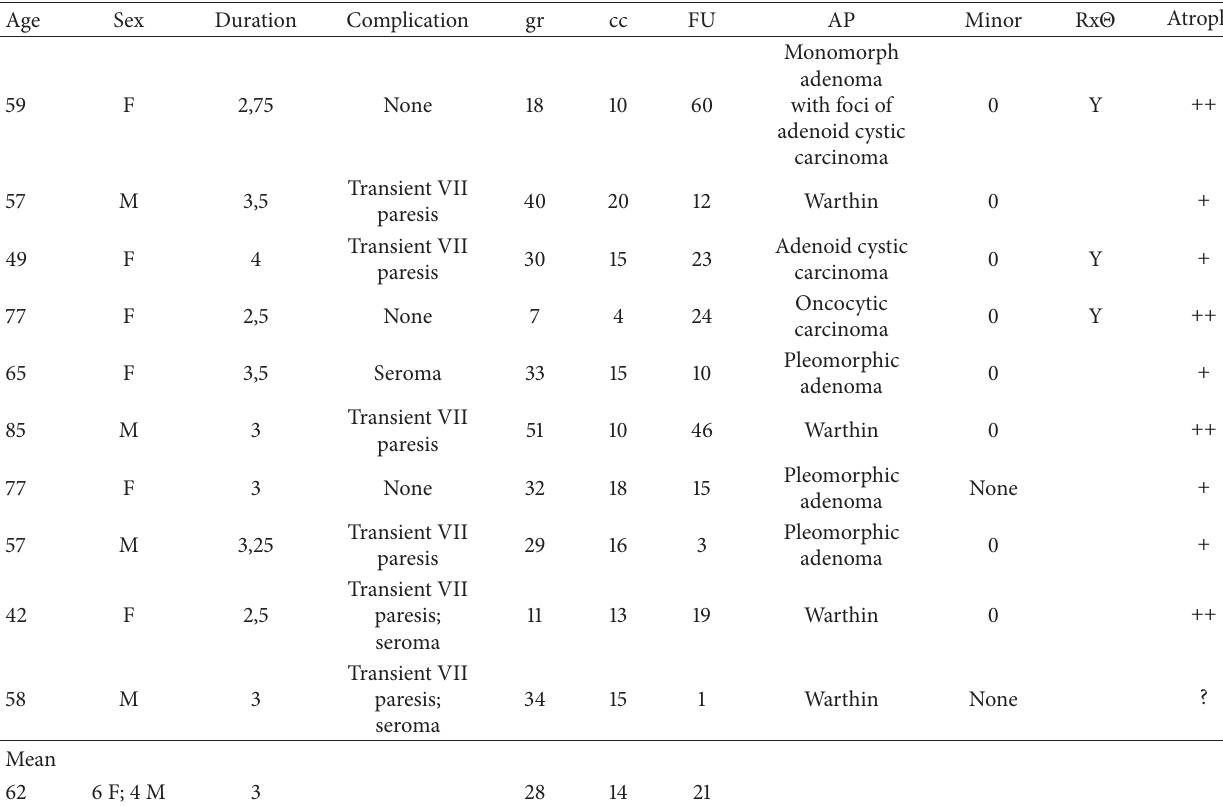
Table 1: Patients’